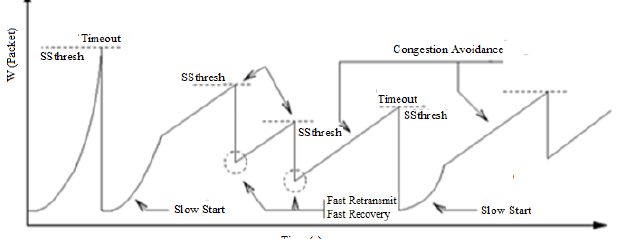
Figure 2. The control mechanism of